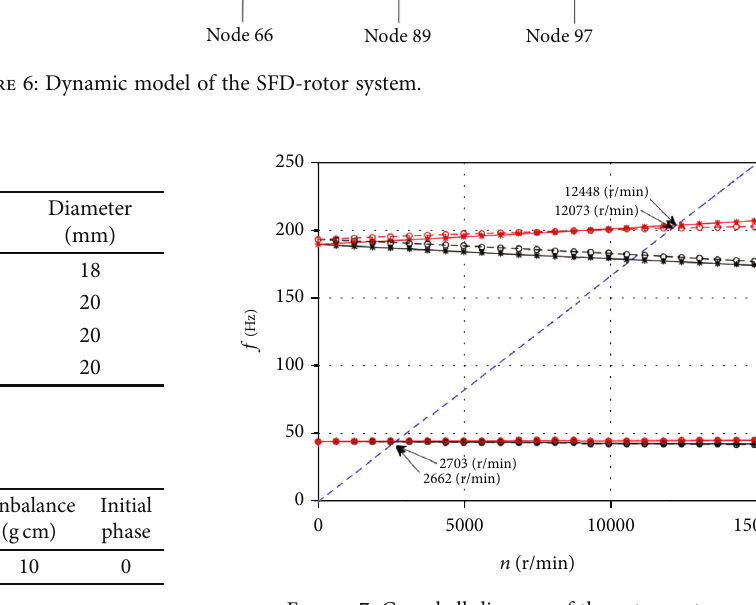
Figure 7: Campbell diagram of the rotor